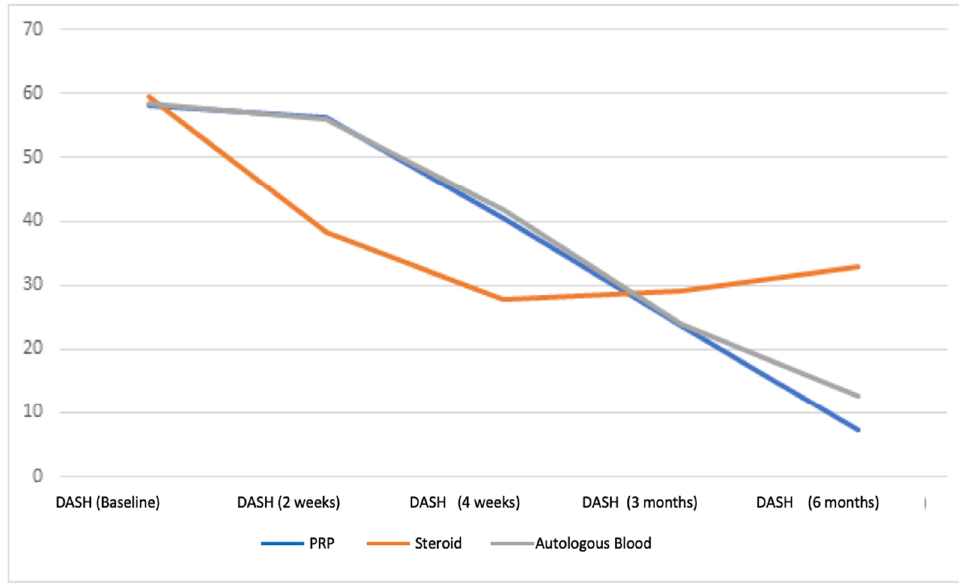
Figure 2. Mean unit improvement in DASH score.